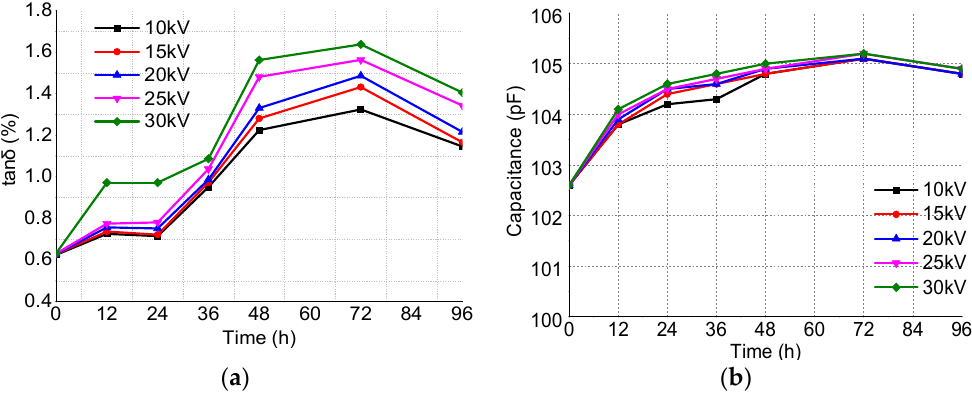
Figure 6. Comparison of the tanδ and capacitance under different voltage. ( a ) tanδ; ( b ) Capacitance.